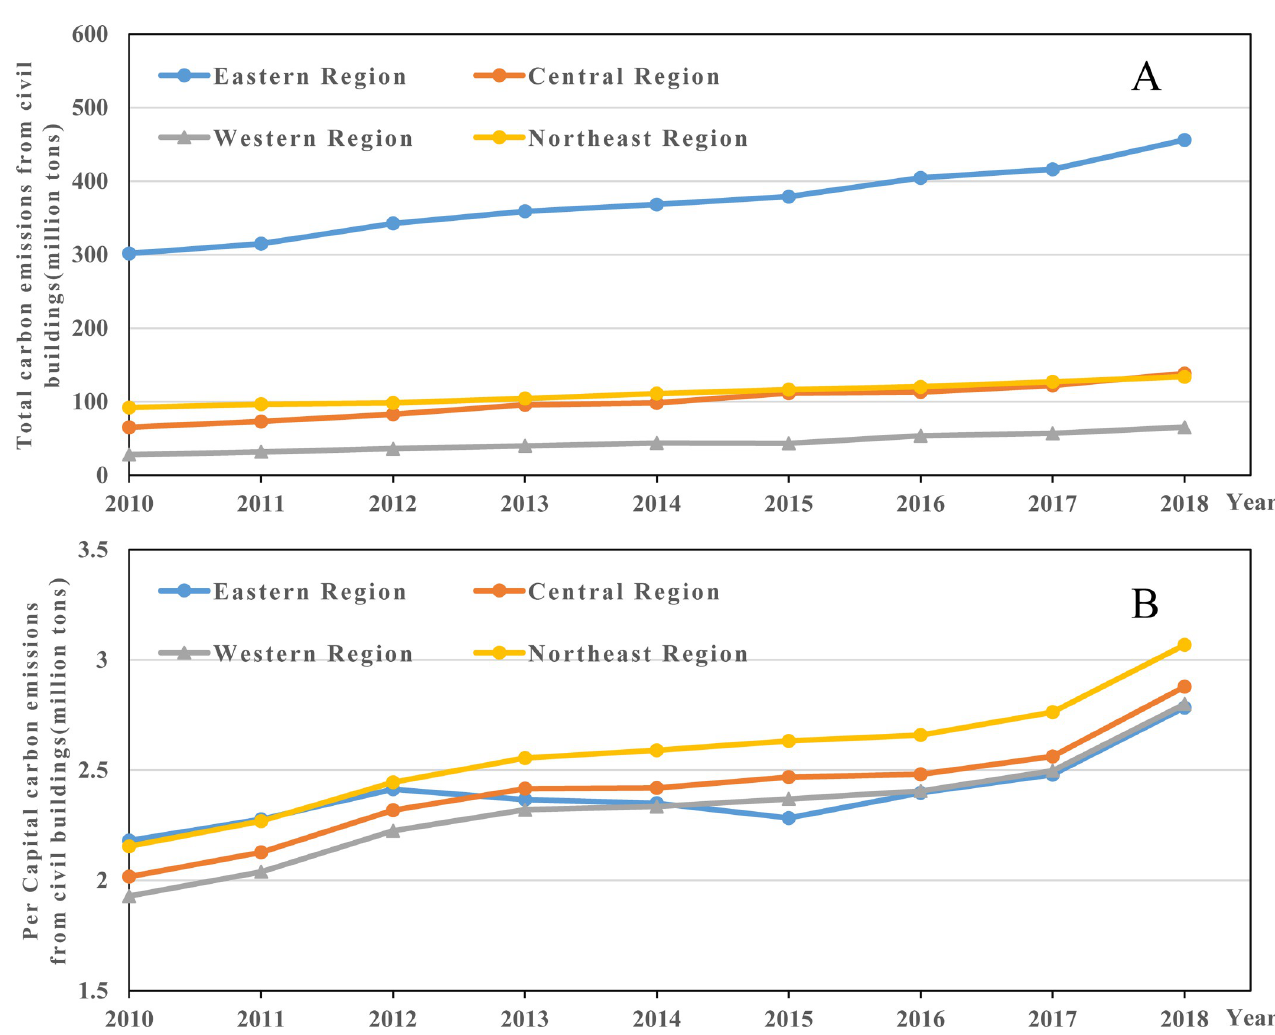
Fig 2. The temporal trend of total carbon emissions from civil buildings (A) and per capita carbon emissions from civil buildings (B) in four major Chinese